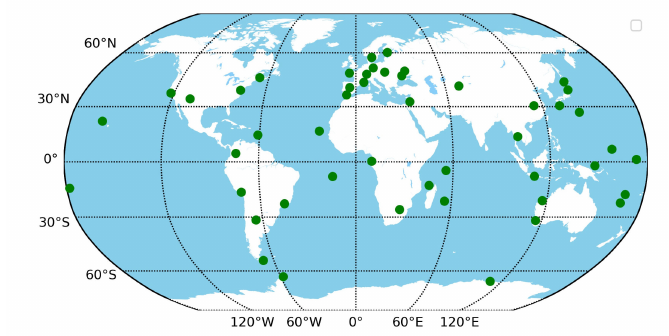
Figure 8. Geographical distribution of the selected Multi-GNSS Experiment (MGEX)